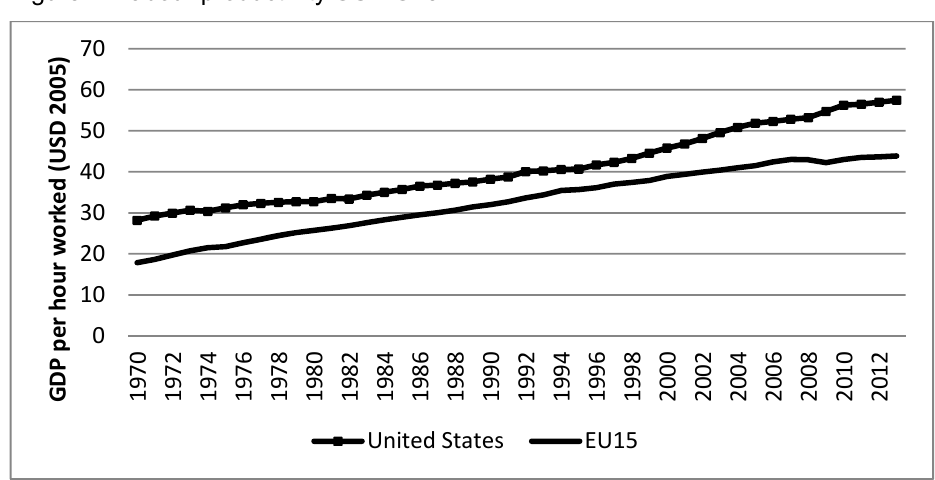
Figure 1. Labour productivity US-EU15